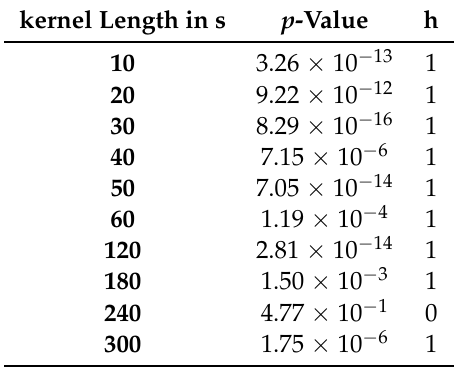
Table 7. Context 1, Scenario 2: Statistical significance of prediction accuracy between multi-layered perceptron artificial neural network (MLP) and random forest (RF)-based classifiers at 5% significance level. A p -value ≤ 0.05 and h -value = 1 signifies the result is statistically